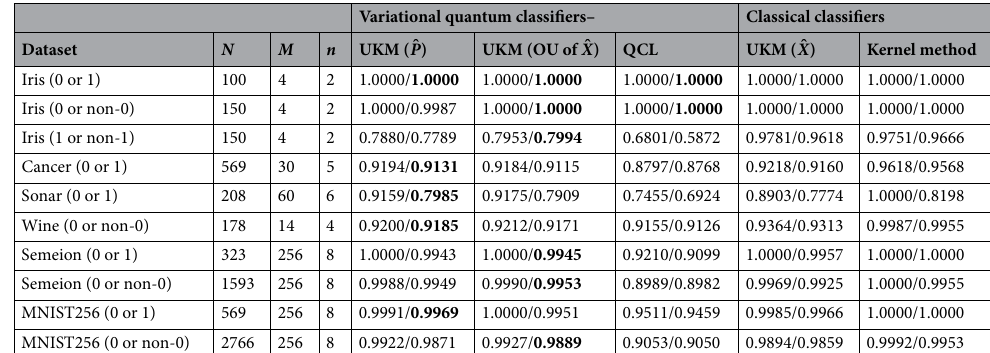
Table 1. Results of 5-fold CV with 5 different random seeds of the UKM ( ˆ X , ˆ P , and OU of ˆ X ), QCL, and the kernel method for all the datasets. The numbers of data points N and dimensions M of the datasets are shown. The number of qubits n required for amplitude encoding is also shown. Note that n = ⌈ log 2 M ⌉ . The performance cells are of the format “training performance/test performance.” We choose the model that shows the best test performance for each algorithm. For the UKM, we consider the complex and real cases with and without the bias term. We set r = 0.010 . For QCL, we consider the CNOT-based, CRot-based, 1d-Heisenberg, and FC-Heisenberg circuits with and without the bias term for the iris, cancer, sonar, and wine datasets, and the CNOT-based and CRot-based circuits with and without the bias term for the semeion and MNIST256 datasets. We set the number of layers L to 5. For φ( · ) in the kernel method, we consider linear and quadratic functions with and without the bias term for (cid:31) = 10 − 2 , 10 − 1 , 1 . The values of the best VQC for each dataset are printed in bold.